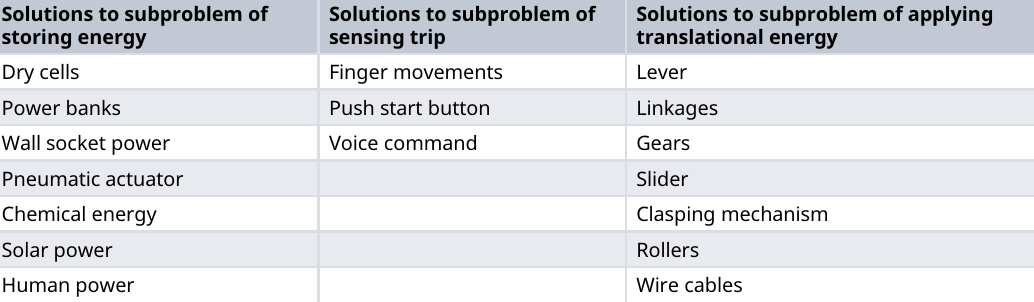
Table 6. Solutions for subproblems on storing energy, sensing trip, and applying translational